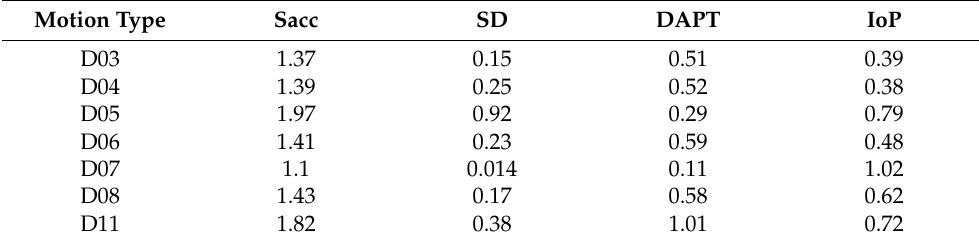
Table 3. Feature values of different motions.